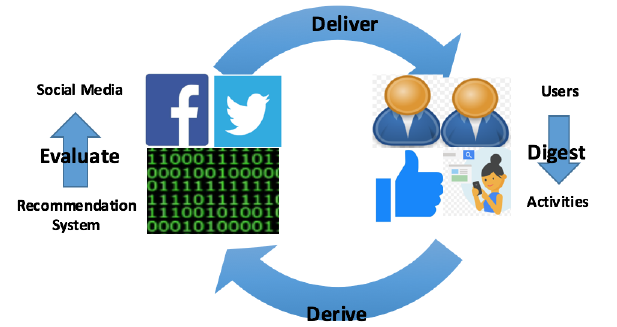
Figure 3. The framework of users activities regarding online social